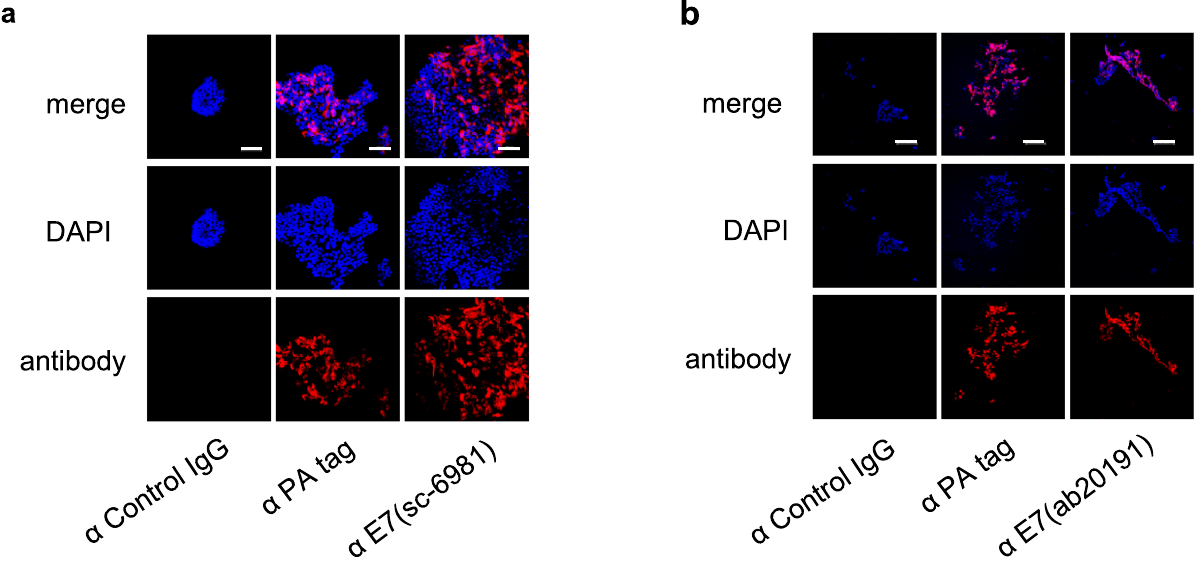
Figure 3. Immunofluorescence analysis of E7 protein using 293FT cells with the overexpressed E7 proteins. ( a , b ) Anti-E7 antibodies ( a sc-6981 and b ab20191) that were able to detect the E7 protein in western blotting were used for immunofluorescence analysis of 293FT cells transfected with pCAGIP-PA-E7. DAPI was used for nuclear staining. Scale bar 100 μm.